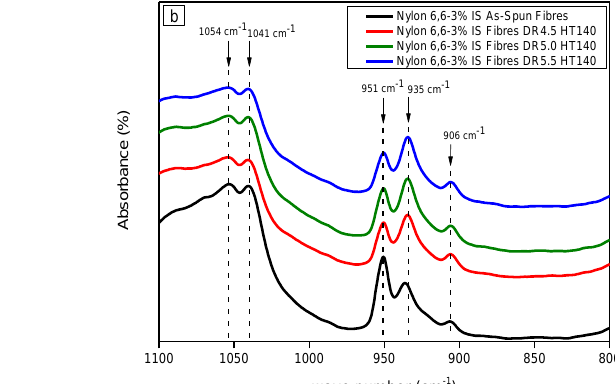
Figure 2. The FTIR spectra of the as-spun and drawn salt-confined nylon 6,6 fibres at the drawing temperature of 140 °C at the band regions of ( a ) 1500 – 1100 cm − 1 and ( b ) 1100 – 800 cm − 1 .